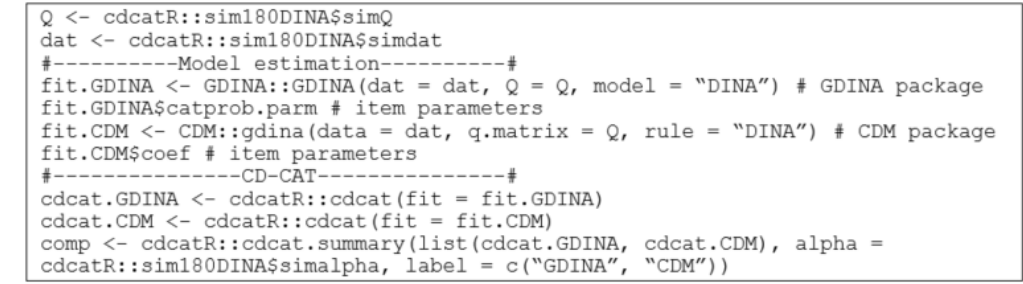
Figure 3. Item bank calibration using the GDINA and CDM packages of the data contained in the sim180DINA object included in the cdcatR package.